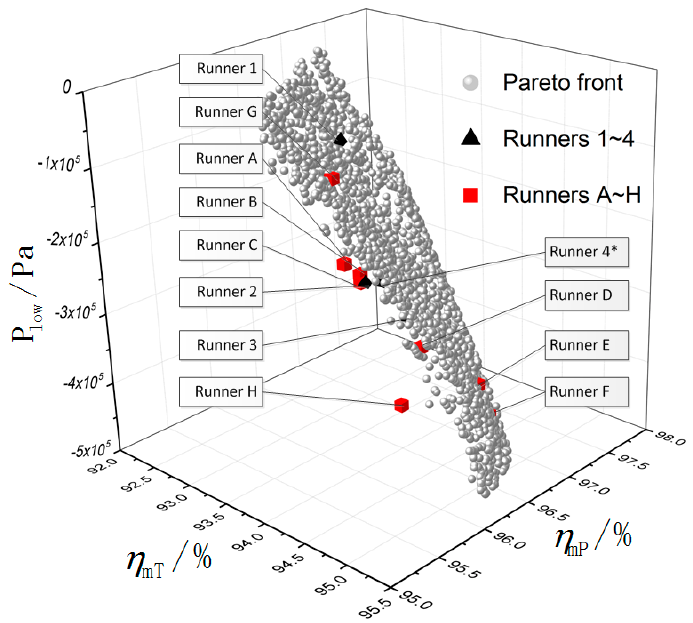
Figure 9. Selected runners and Pareto front surface.